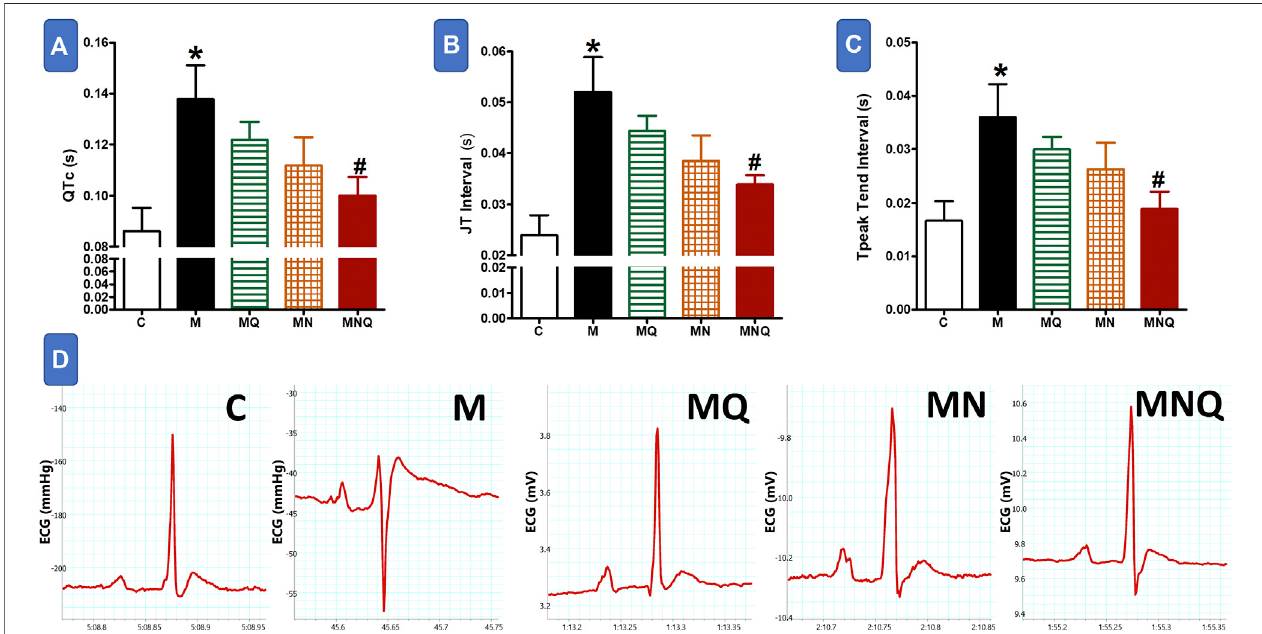
FIGURE 2 | Effect of oral administration of standard quercetin suspension (MQ), plain nano-pharmaceutical formulation (MN) and the quercetin loaded nano- pharmaceutical formulation (MNQ) both at 83 μ mol/kg/day on QTc (A) , JT interval (B) and PR interval (C) in metabolic syndrome (M) induced by feeding rats a high fructose (10% in drinking water), high salt (3%) and high fat (25%) diet for 12 weeks. Panel D shows representative original recording of ECG. Results are expressed as mean ± SEM(n (cid:2) 8forallgroups). * p < 0.05whencompared tothecorrespondingcontrol(C)values,# p < 0.05whencomparedtothecorrespondingMetSvalues using one-way ANOVA followed by Dunnet ’ s post-hoc